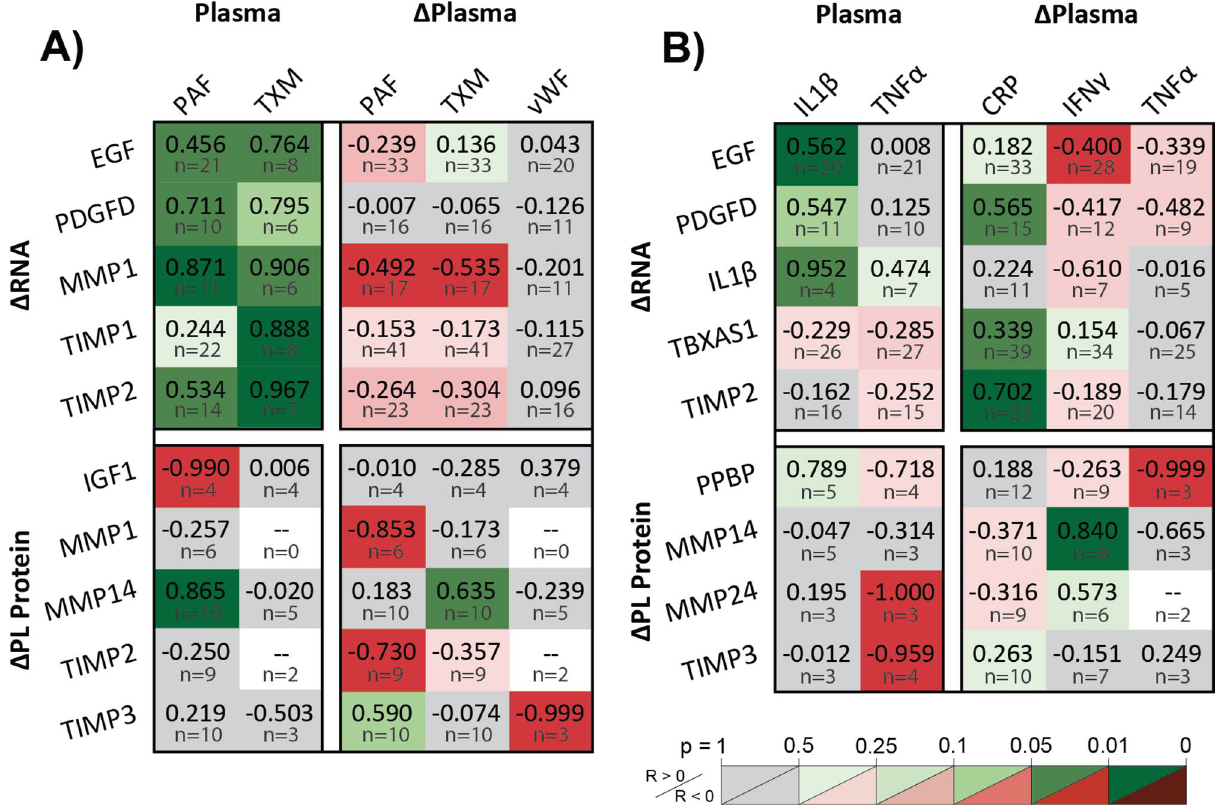
Figure 4. Elevated activation and inflammatory state indicate platelet dysfunction. Pearson correlation coefficients, R, of intra-dialysis platelet lysate RNA or protein relative changes against pre-dialysis plasma protein levels or intra-dialysis plasma relative changes, categorized by interpreted effects on platelets caused by ( A ) coagulative and ( B ) inflammatory indicators. ( A ) Platelet ΔRNA correlates positively to pre-dialysis levels of coagulative indicators and negatively to intra-dialysis protein changes, revealing targets of selective megakaryocyte upregulation and stimulated synthesis during dialysis. Platelet proteome correlations to plasma support acute MMP and TIMP exocytosis during dialysis and elevated chronic membrane-type MMP14 presentation with plasma levels of platelet activators. Increasing acute MMP and TIMP ΔRNA with increasing chronic plasma indicators, coupled with decreasing ΔRNA with increasing acute Δplasma indicators attributed to translation and degradation support MMPs and TIMPs as platelet-mediated targets causing dysfunction. ( B ) Platelet secretome correlations to chronic levels and acute changes in plasma inflammatory markers show platelet contributions to inflammatory and regenerative response. EGF is chronically enhanced and acutely synthesized, while IL1β is chronically amplified in platelets. Meanwhile, PDGFD, TIMP2, and TBXAS1 RNA are protected with acute inflammation. Membrane-type MMPs appear to be chronically suppressed and acutely enhanced, while TIMP3 synthesis is chronically suppressed and PPBP is acutely secreted. Figure was prepared in Matlab R2019 (Mathworks, Nattick MA, www. mathw orks. MMP3 and CTGF production are attenuated by higher plasma PGI2. Thus, normal restorative platelet inhibition indicates lower platelet dysfunction. Faster BFR and longer HD Vintage exacerbate platelet dysfunction. Comparisons of platelet RNA and protein levels against clotting factors indicate broader effects of BFR and Vintage on long-term platelet translation and secretion. Faster BFR increasingly stimulates platelet dysfunction, shown by comparison of pre-HD plasma PAF to BFR (Fig. 1D) by multivariate linear regression. Similarly, stimulation of platelet RNA renewal and degranu- lation with plasma clotting factor elevation depict a mechanism of increasingly stimulated platelet dysfunc- tion with BFR (Fig. 4A). Decreasing plasma ΔPAF and ΔTXM with both higher BFR and Vintage, respectively (Fig. 2B, C), and increasing ΔMMP1 RNA and PL ΔMMPs and ΔTIMPs with decreasing ΔPAF and ΔTXM (Fig. 4A) show preferential augmentation of platelet MMPs and TIMPs with increasing BFR and Vintage. Fur- ther, platelet-driven mechanisms causing tissue dysregulation appear to extend between HD sessions, shown by the significant relative increases in clotting factor RNA post-HD. Thus, in addition to directly enhancing platelet PAF RNA (Fig. 3B), faster BFR and longer Vintage may cause platelet behavioral adaptations that reduce regen- erative contributions and disrupt proteolytic balance.